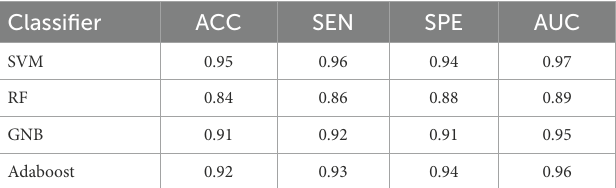
TABLE 4 Classification results of different classifiers in the test set.